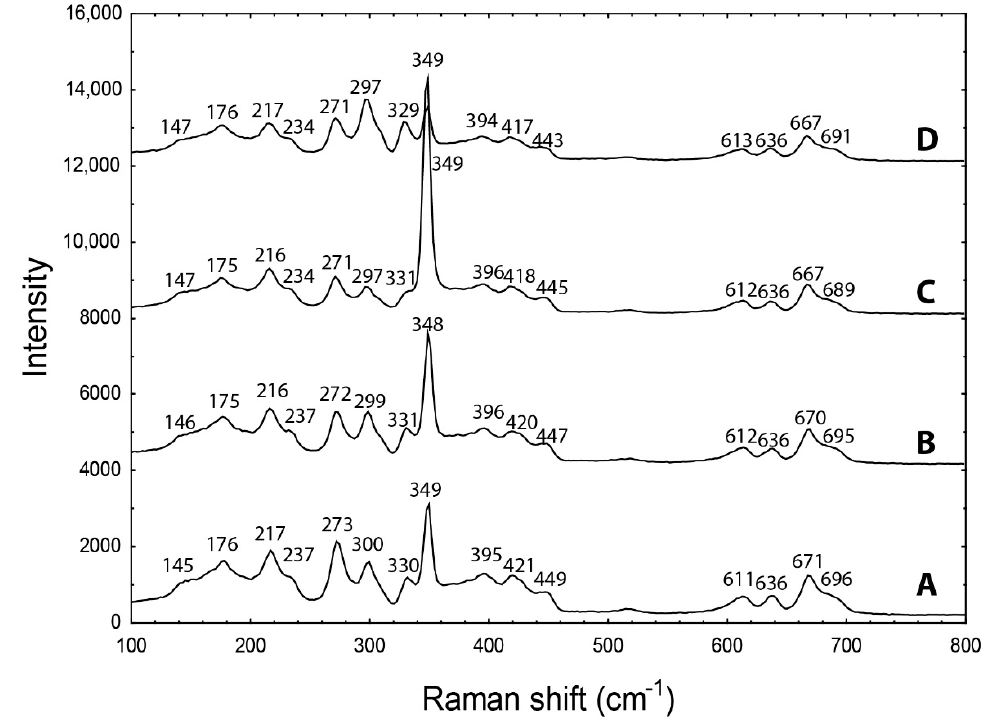
Figure 4. Raman spectra of studied sphalerite samples.